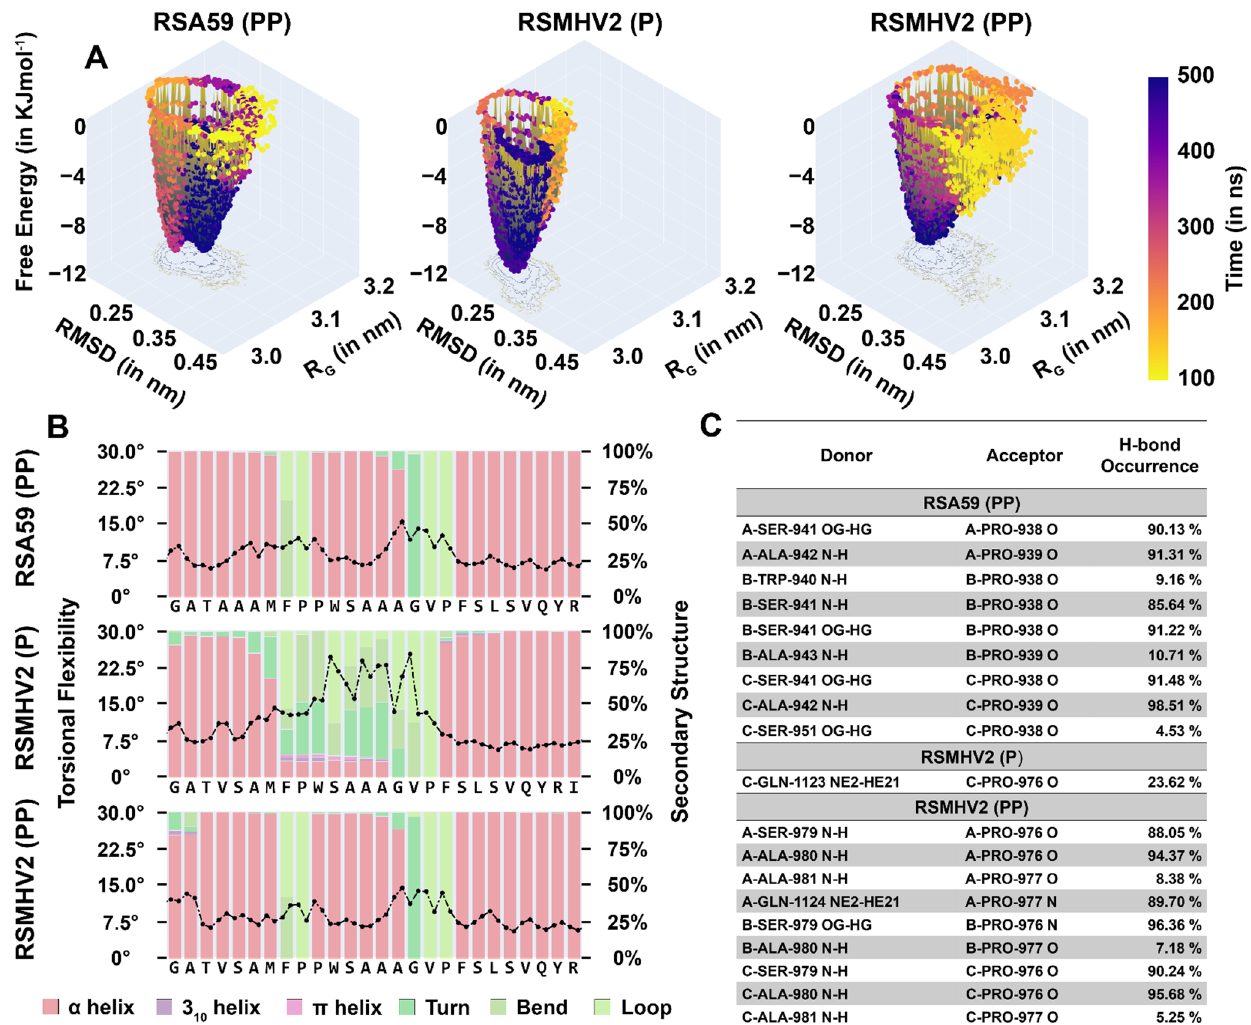
Figure 10. Results from the analysis of MD simulations of Spike from RSA59 (PP), RSMHV2 (P), and RSMHV2 (PP) in water . ( A ) Free energy landscapes of spike proteins from RSA59 (PP), RSMHV2 (P), and RSMHV2 (PP) from root-mean-square deviation and radius of gyration of the trajectory between 100–500 ns. The trajectory points are plotted on the surface and colored according to time as given by the color bar. ( B ) Torsional flexibility and secondary structure of the fusion domain in the three simulations. The two markers for each residue correspond to ϕ and ψ backbone torsion angle. The stacked bar for each residue shows the percentage of frames for which the secondary structure was observed. Since the three chains of the spike protein are identical and their results were similar, the results for the three chains were averaged. ( C ) Hydrogen bonds with the central proline/prolines in the FP. The donor and acceptors are given in the following format ‘Chain-Residue-Residue number Atom name’; the donor is also suffixed with ‘-Hydrogen atom